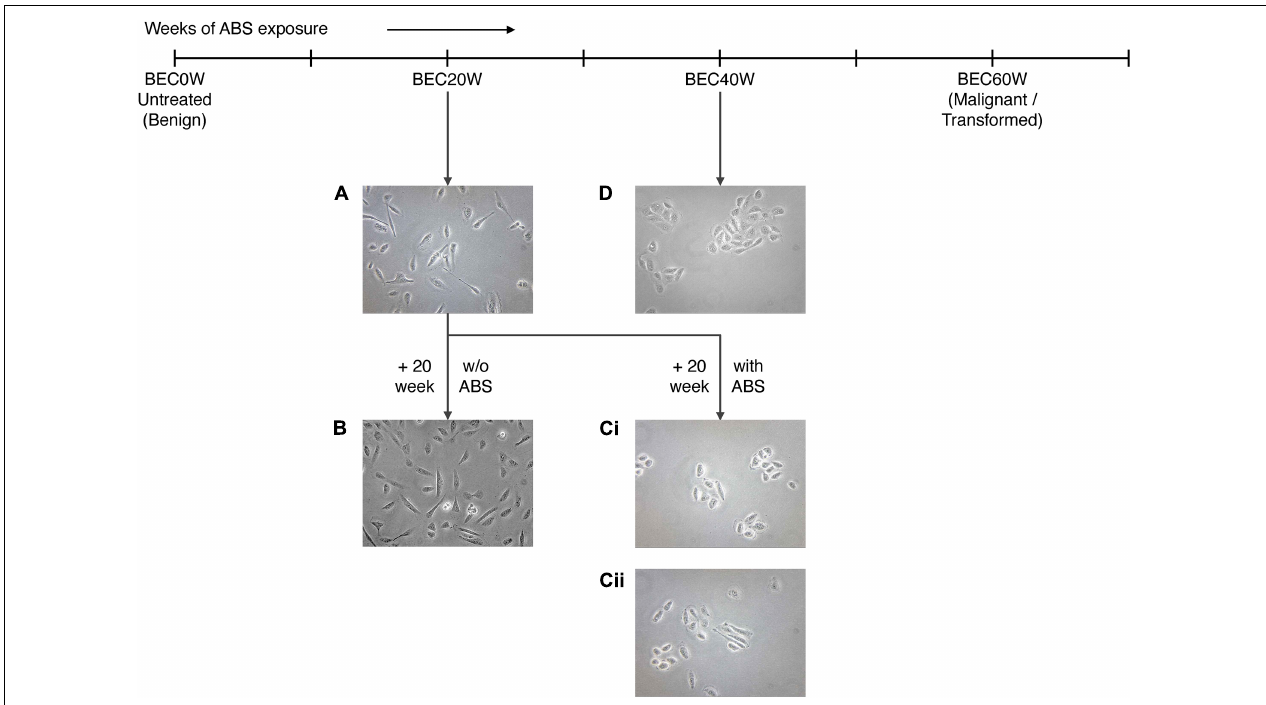
FIGURE 3 | Morphological changes in BEC20W cells further exposed to acid and bile salt (ABS) for 20 weeks: (A) BEC20W cells (B) BEC20W + 20 weeks cells not exposed to ABS retain their elongated morphology and disperse evenly on the surface of the cell culture plates. (C) BEC20W + 20 weeks cells further exposed to ABS for another 20 weeks transform into oblong morphology and exhibit increased cell–cell cohesion (Ci,ii) similar to the BEC40W cells (D)